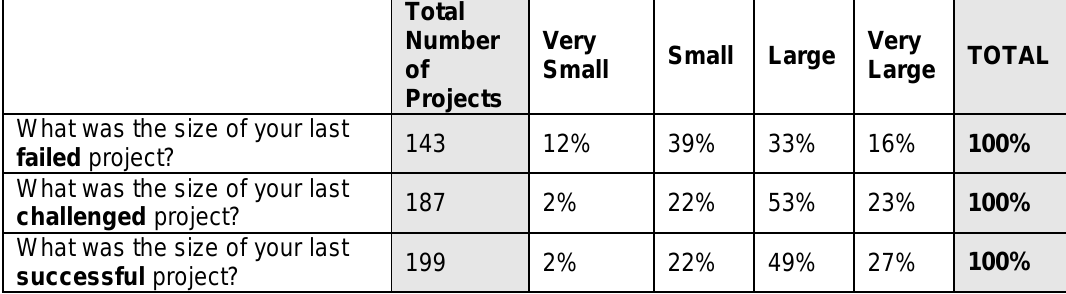
Table 2: Project size in relation to project outcome